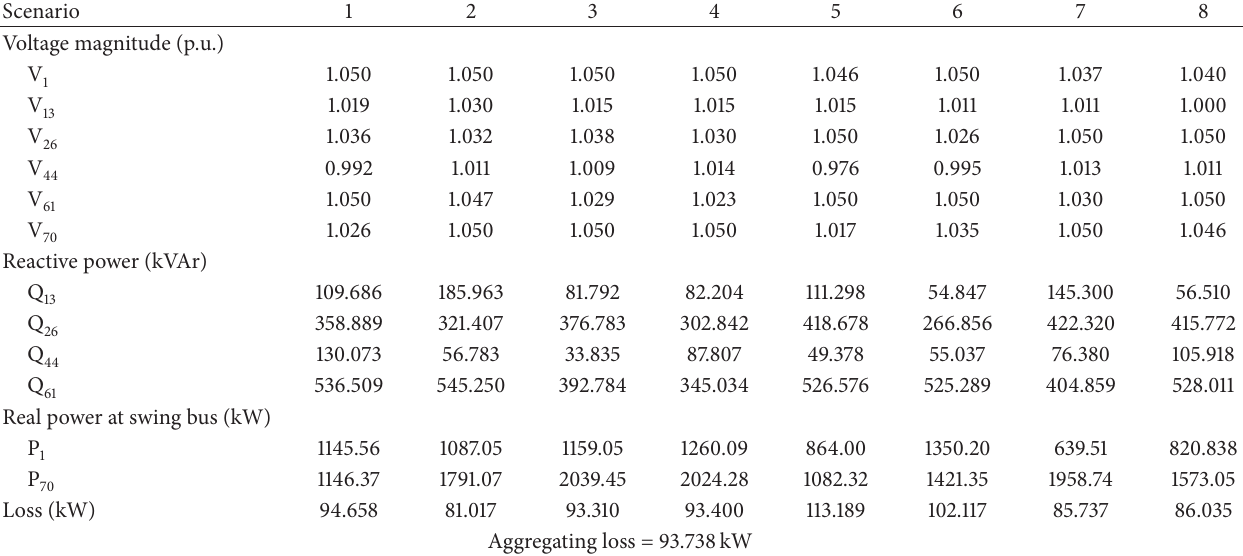
Table 6: Optimal results after feeder reconfiguration using chaos-based PSO and